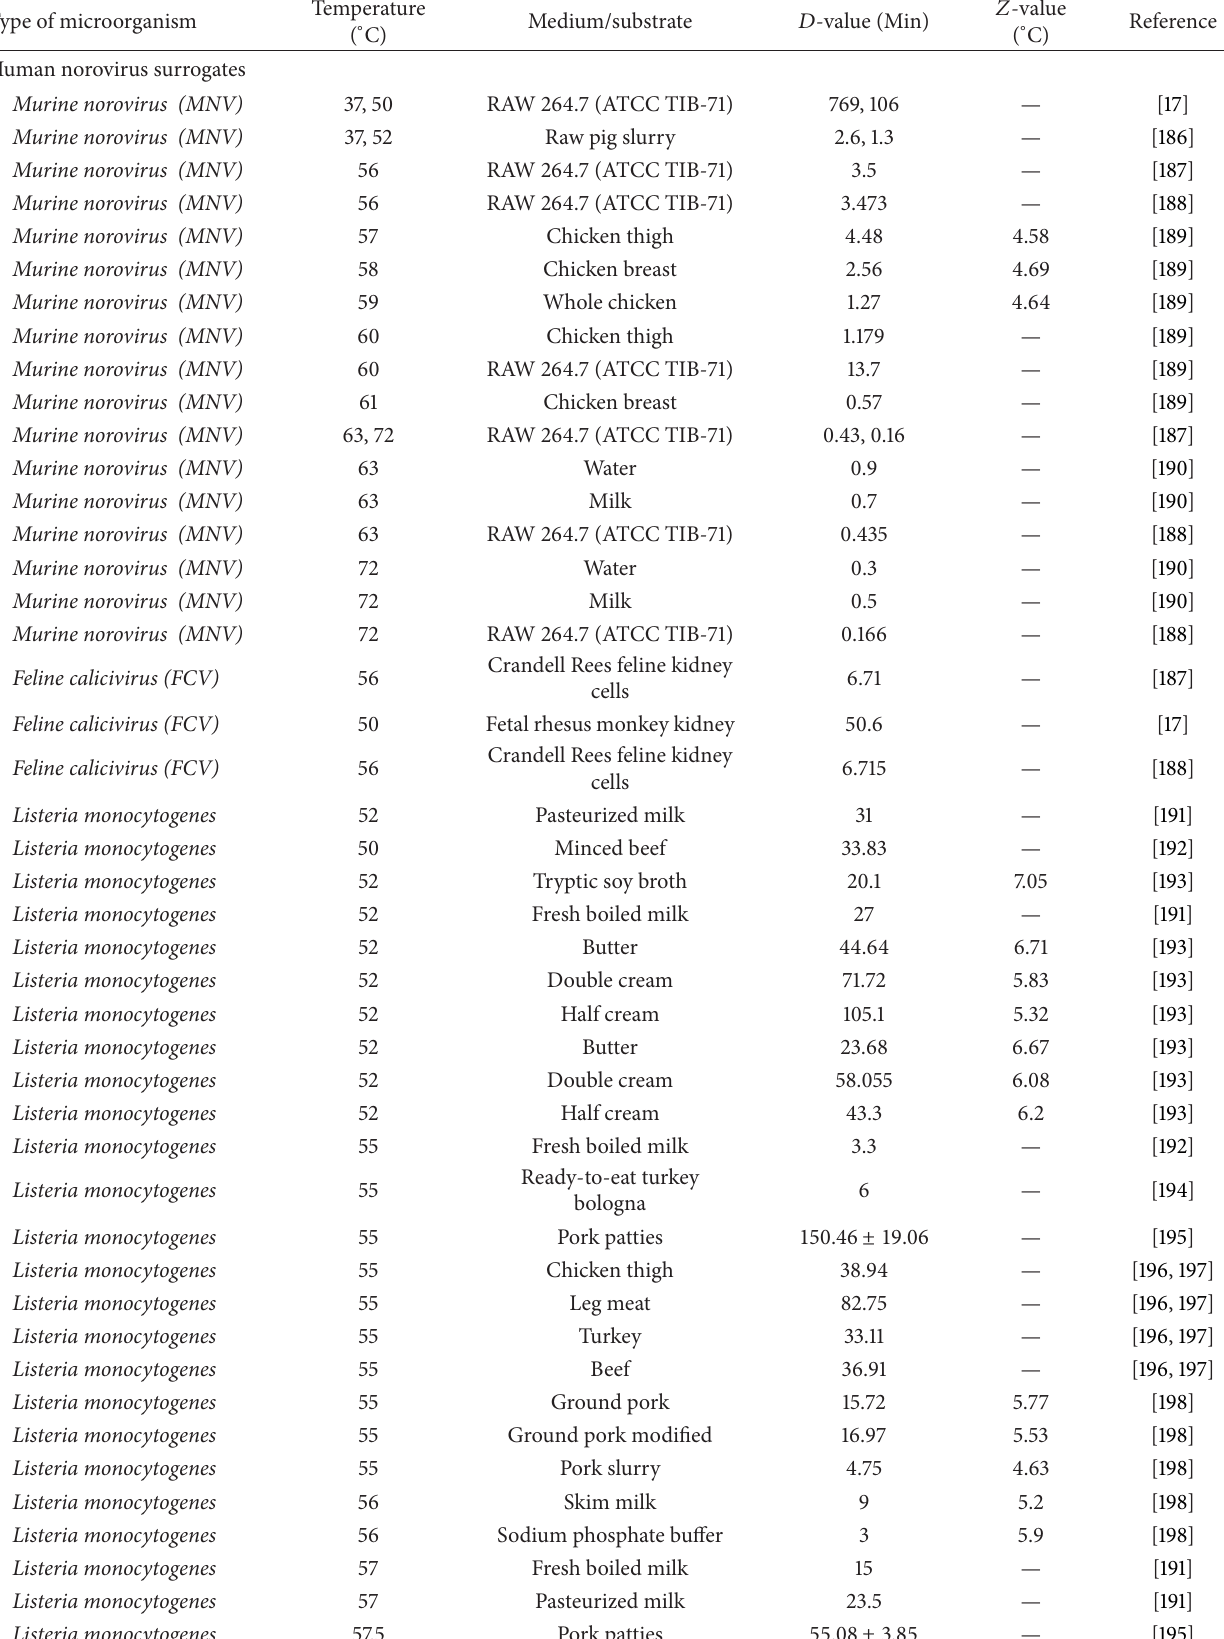
Table 3: Kinetic factors for microbial inactivation.